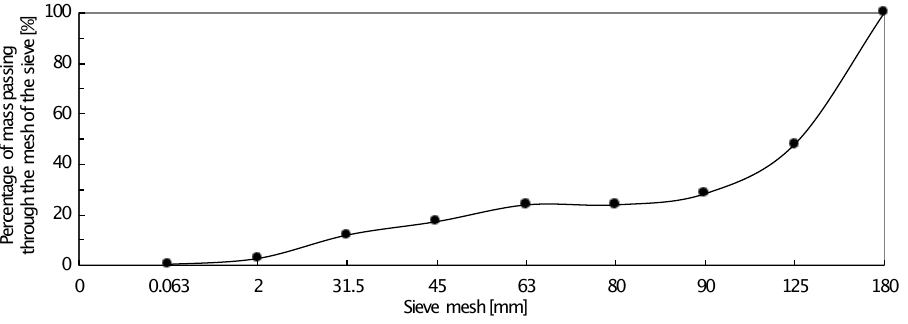
Figure 3. Cumulative particle size